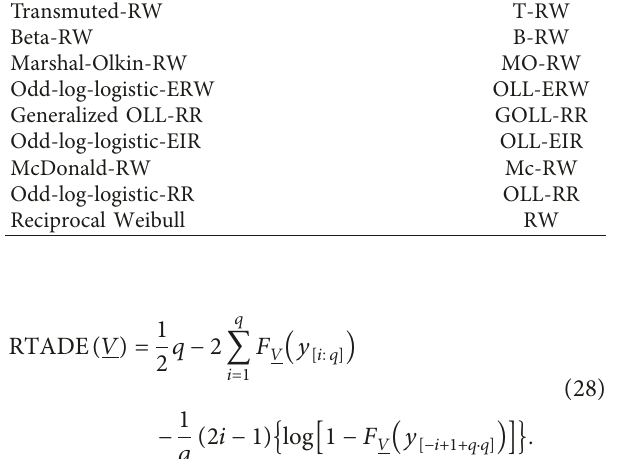
Table 6: Assessment results for parameters a